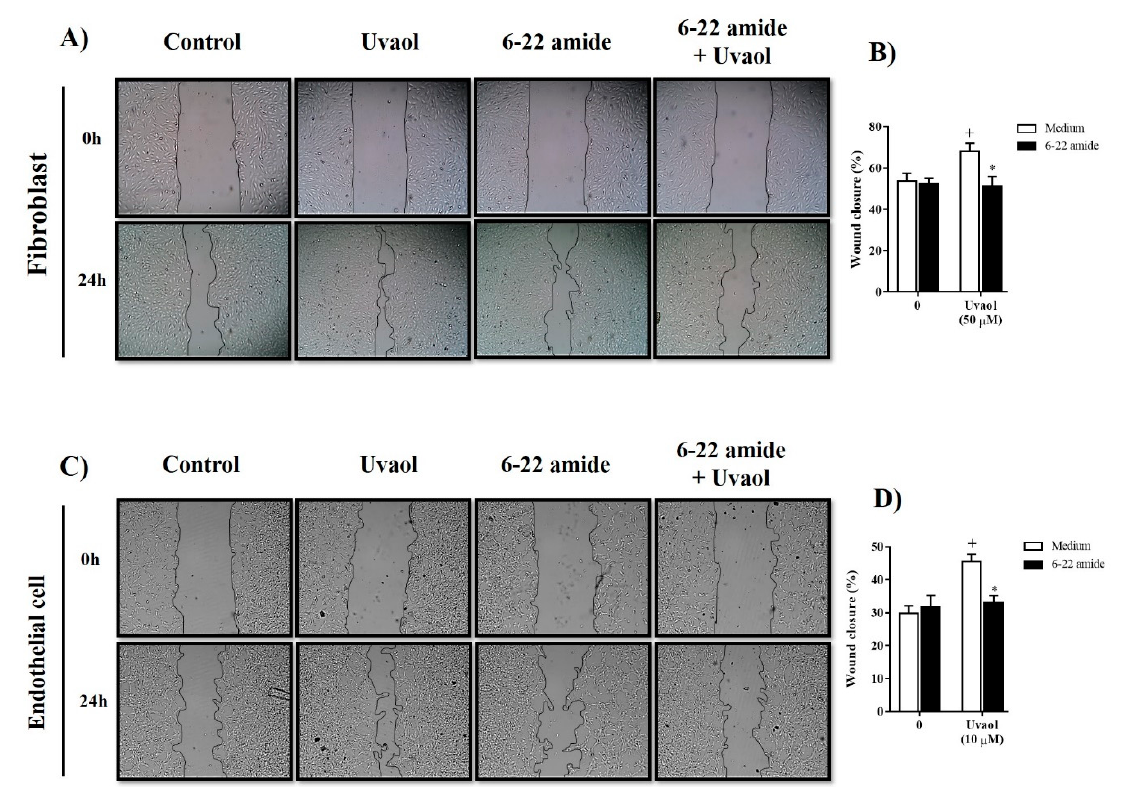
Figure 6. Inhibition of the PKA signaling pathway attenuates the migration of fibroblast and endothelial cells induced by uvaol. Scratch wounds were created in cell monolayers of cells using a sterile pipette tip. Representative photomicrography images showing the scratched area of fibroblasts ( A ) and endothelial cells ( C ) cultured with medium, uvaol or (6-22)-amide (a PKA inhibitor, 10 µM) in the presence of uvaol for 24 h (magnification 40×). The percentage of the scratch covered was measured by quantifying the total distance that cells moved from the edge of the scratch towards the center of the scratch, using ImageJ software, followed by conversion to a percentage of the wound that was covered ( B , D ). The bars represent mean ± SD of three independent experiments. Statistical differences were detected with two-way ANOVA followed by the Bonferroni test. (+) p < 0.01 compared to medium-treated cells, (*) p < 0.05 compared to uvaol-treated